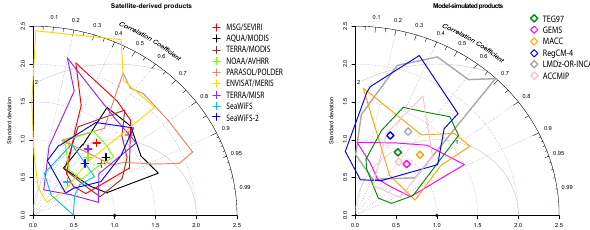
Fig. 6. Taylor diagrams evaluating satellite data (left) and model Fig.6. Taylordiagramsevaluatingsatellitedata(left)andmodeldata(right)againstAERONETobservationsintermsoftemporalcorrelation for47stationsaroundtheMediterraneanbasin. data (right) against AERONET observations in terms of temporal correlation for 47 stations around the Mediterranean